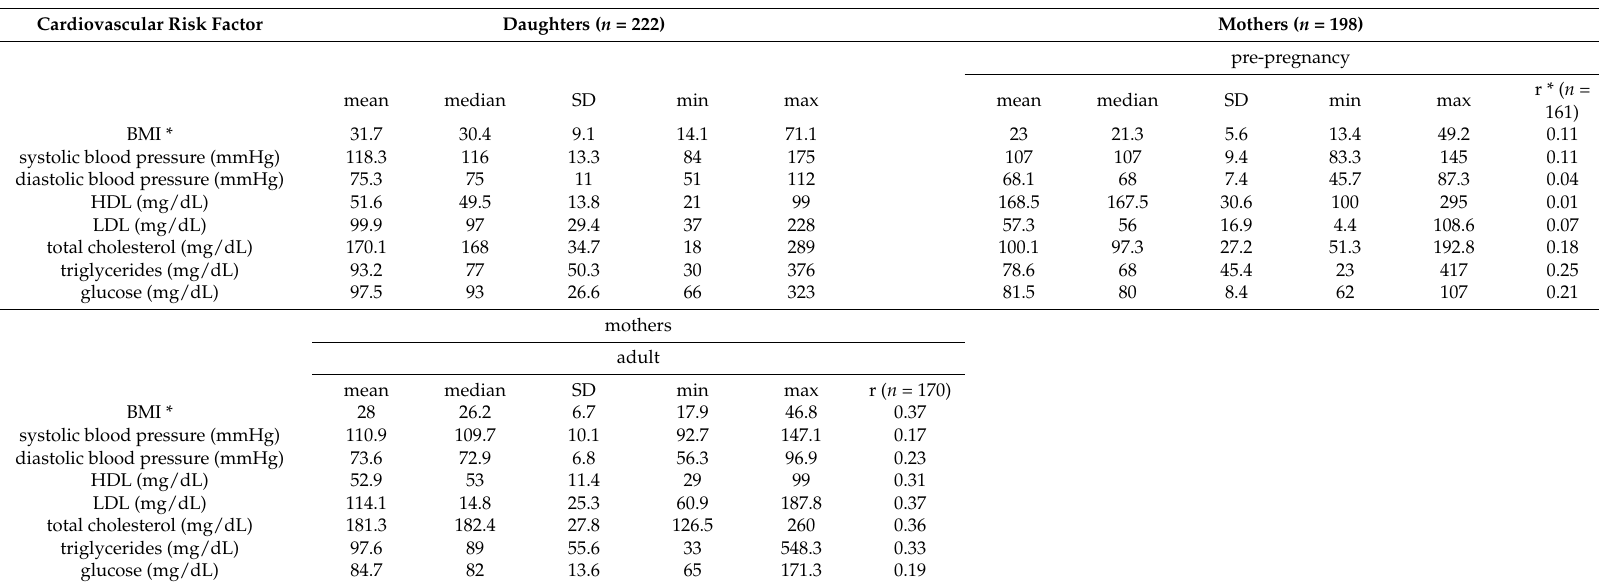
Table 2. Adiposity and cardiometabolic health across generations. The Bogalusa Daughters study. Cardiovascular Risk